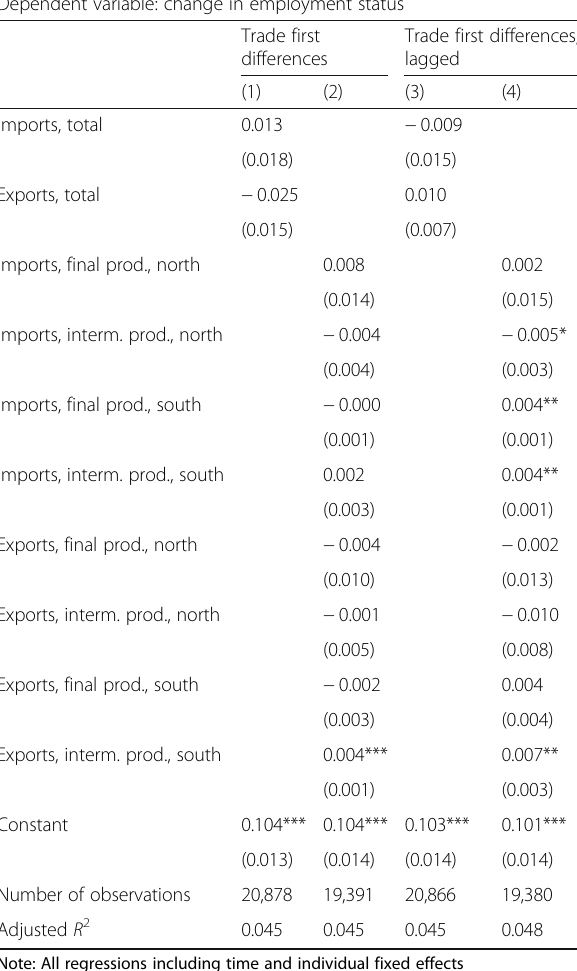
Table 3 Linear regressions of changes in employment status on trade levels using individual fixed effects